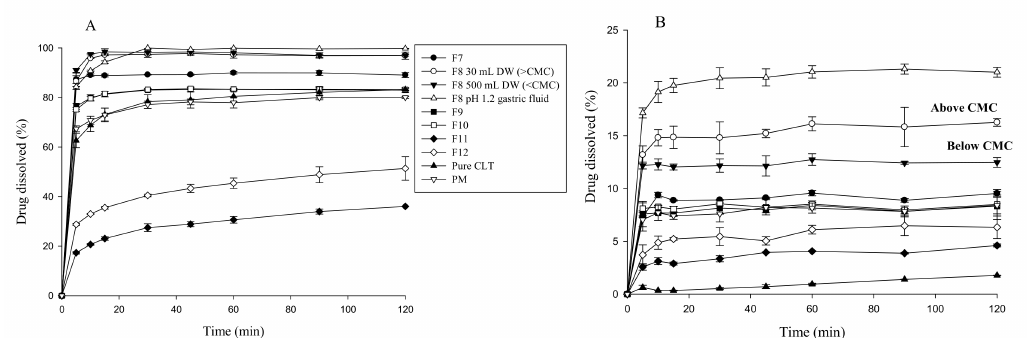
Figure 1. Dissolution profiles of cilostazol (CLT), physical mixture (PM), and solid dispersions (SDs) prepared by different methods in enzyme-free gastric fluid (pH 1.2) with ( A ) and without ( B ) 0.5% sodium lauryl sulfate (SLS) ( n = 3).